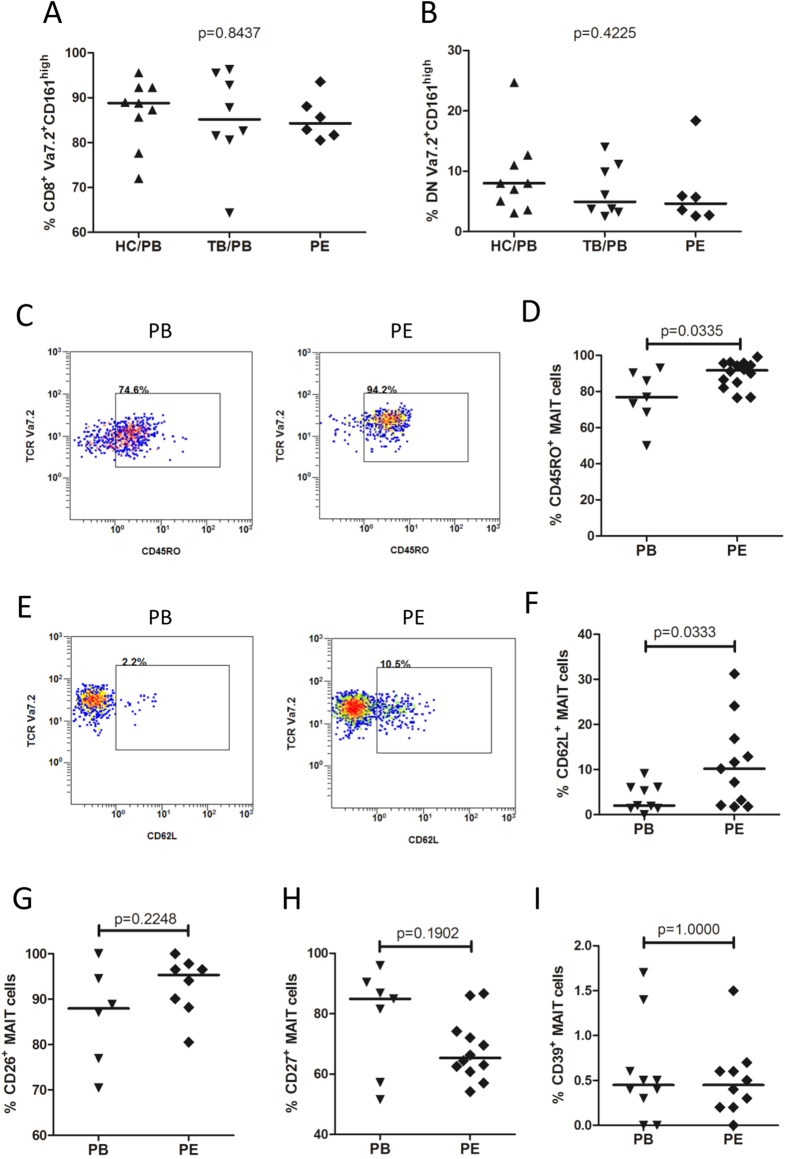
Phenotypic analysis of MAIT cells from tuberculous pleural effusions and peripheral blood.(A) Frequency of CD8α+ MAIT cells in peripheral blood of healthy controls (HC/PB) and patients with TB (TB/PB), and in tuberculous pleural effusions (PE). (B) Frequency of CD4−CD8α− (DN) MAIT cells. (C) Representative flow plots showing expression of CD45RO in MAIT cells from peripheral blood (PB) and tuberculous pleural effusion (PE) in the absence of antigen stimulation. (D) Frequencies of CD45RO+ MAIT cells. (E) Representative flow plots showing expression of CD62L in MAIT cells in the absence of antigen stimulation. (F) Frequencies of CD62L+ MAIT cells. (G–I) Frequencies of CD26+ (G), CD27+ (H), CD39+ (I) MAIT cells in peripheral blood of patients with TB (PB) and in tuberculous pleural effusions (PE) respectively. Horizontal bars in the scatter plots indicate medians. Kruskal-Wallis test was used for statistical analysis among groups in Fig. 3A,B. The nonparametric Mann-Whitney test was used for statistical analysis between groups in Fig. 3D,F,G–I.